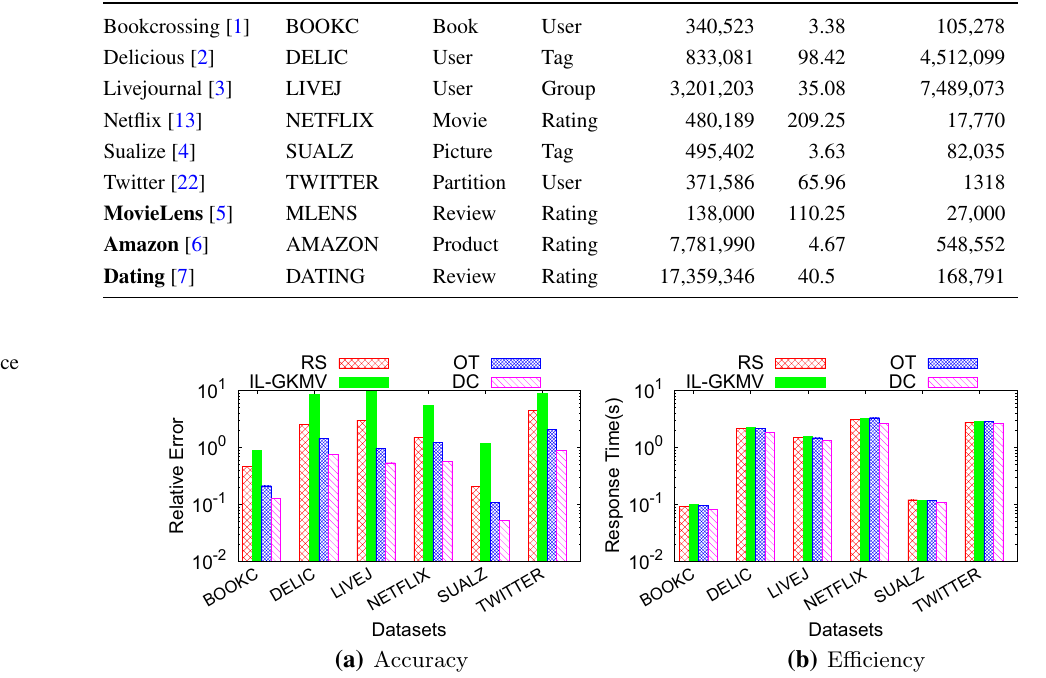
Table 3 Characteristics of datasets